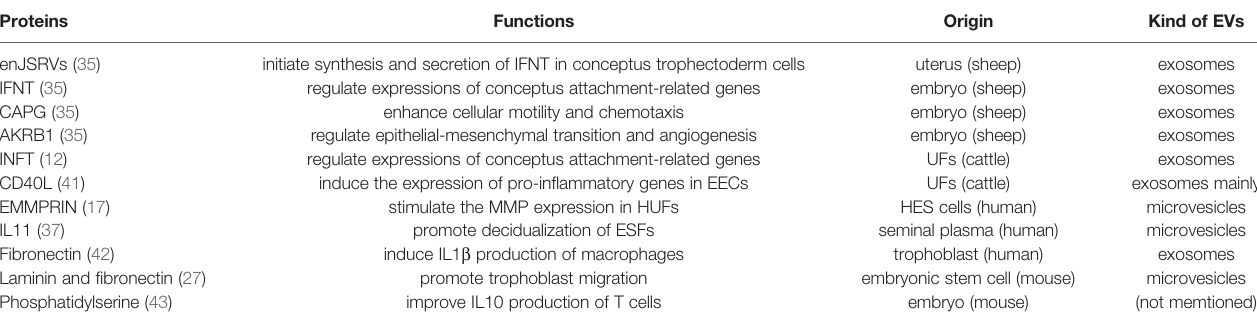
TABLE 1 | EV Proteins and their functions in embryo